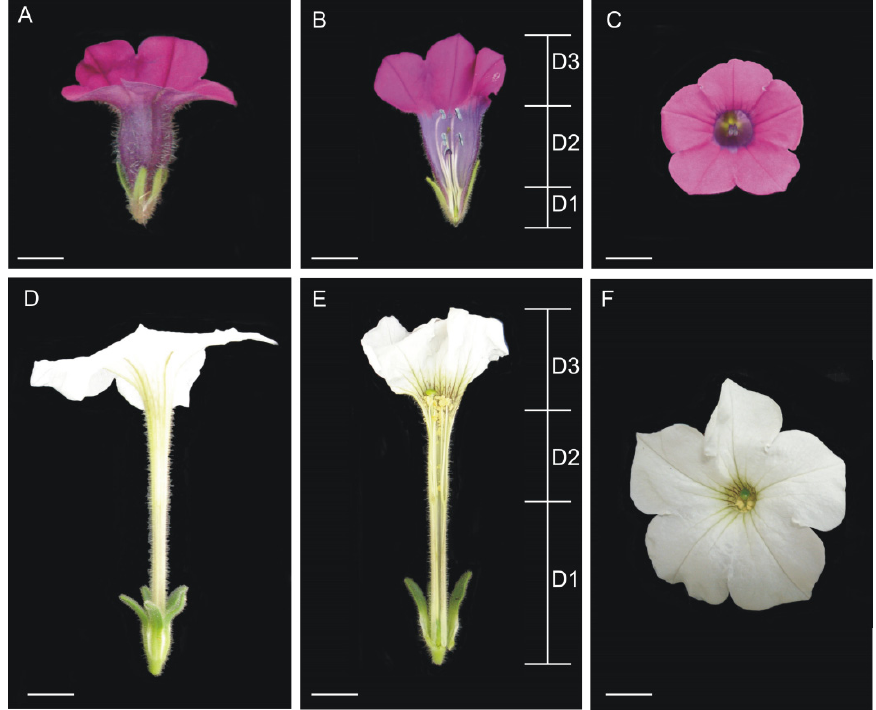
Figure 1. Morphological differences. ( A – C ) Petunia inflata ; ( D – F ) Petunia axillaris ; A and D flowers in side view; B and E flower internal view; with domains D1, D2 and D3 delimited [5]; C and F front view. Bars correspond to 1 cm.